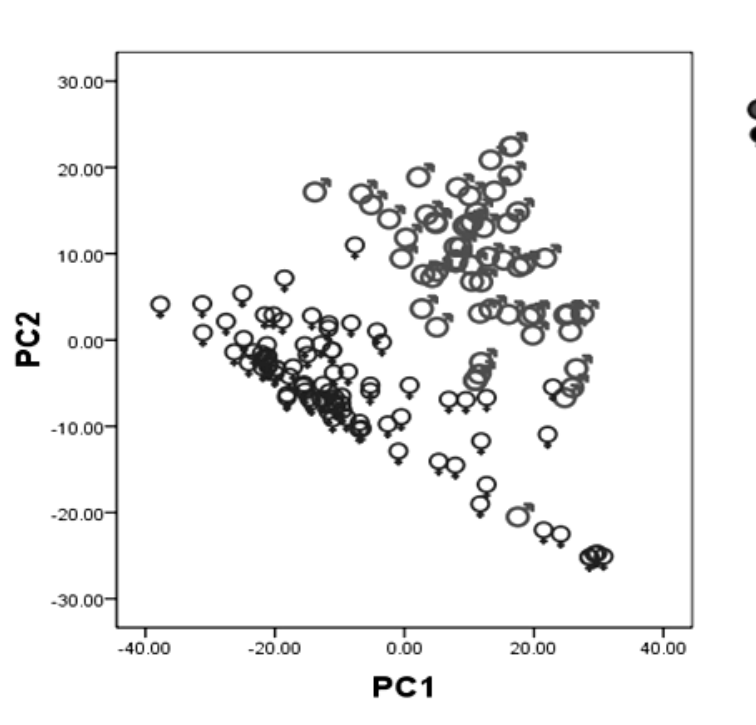
F IGURE 3. The scatter plot resulted from the PCA analysis to showing sexual dimorphism in